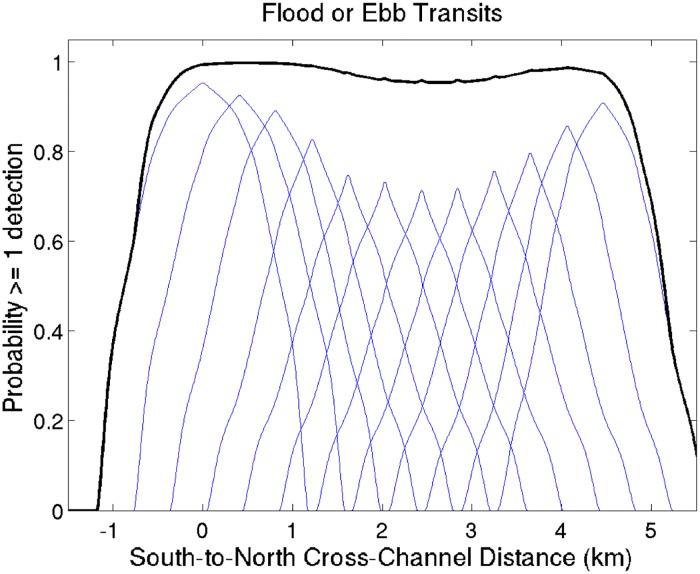
Results of OTN range test experiment calculated by Sanderson et al. (in preparation).Probability of detection of Atlantic sturgeon tagged with V16 acoustic tags (158 db, 75 sec average transmission interval) passing the OTN Minas Passage Line. Individual receivers are represented by blue lines with left hand side representing the south (first blue peak = receiver MPS012) and right side (last blue peak = receiver MPS001). Solid black line represents the probability of a tagged sturgeon being detected by at least one of the receivers. Probability of being detected by at least one receiver is nearly identical for the north and south sections of the line, with a small reduction in probability of detection in the middle.